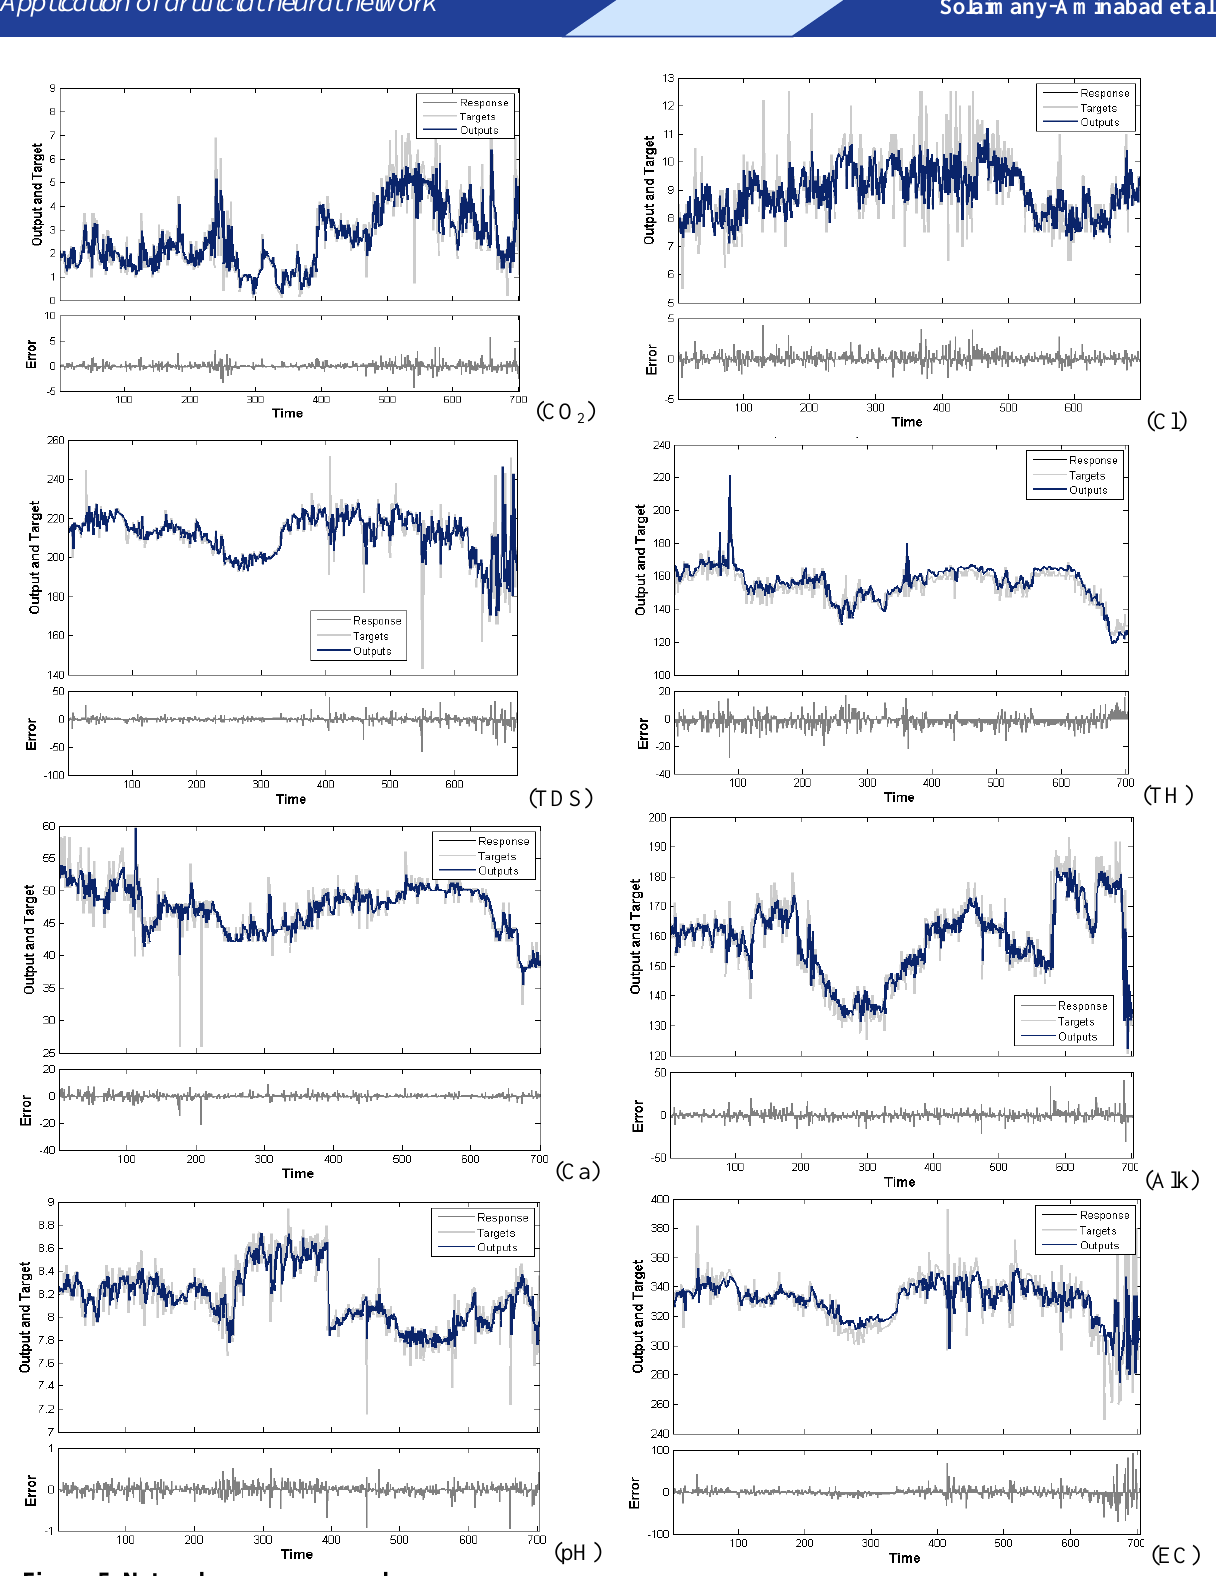
Figure 5. Networks responses and errors TH: Total hardness; TDS: Total dissolved solids; Alk: Alkalinity; EC: Electrical conductivity; Tur: Turbidity; T: